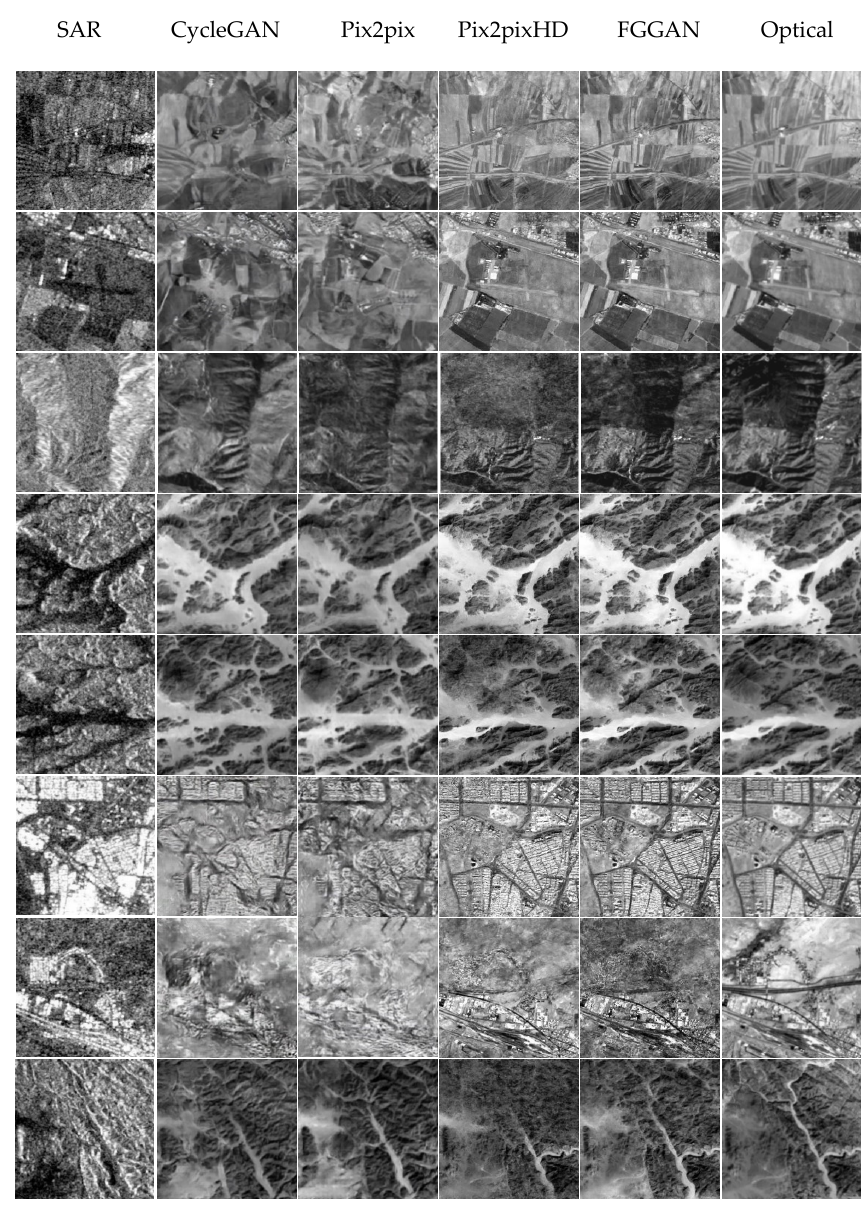
Figure A1. More detailed results of SAR-to-optical image